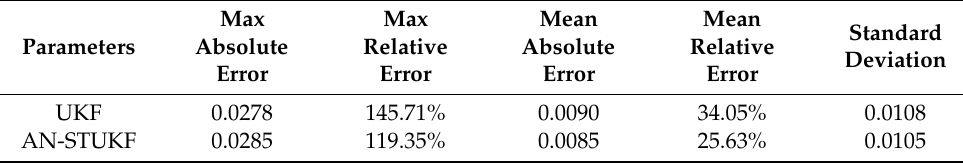
Table 3. Error analyses for S-shape